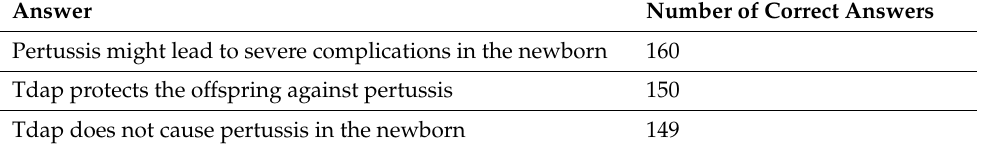
Table 9. Knowledge about Tdap.